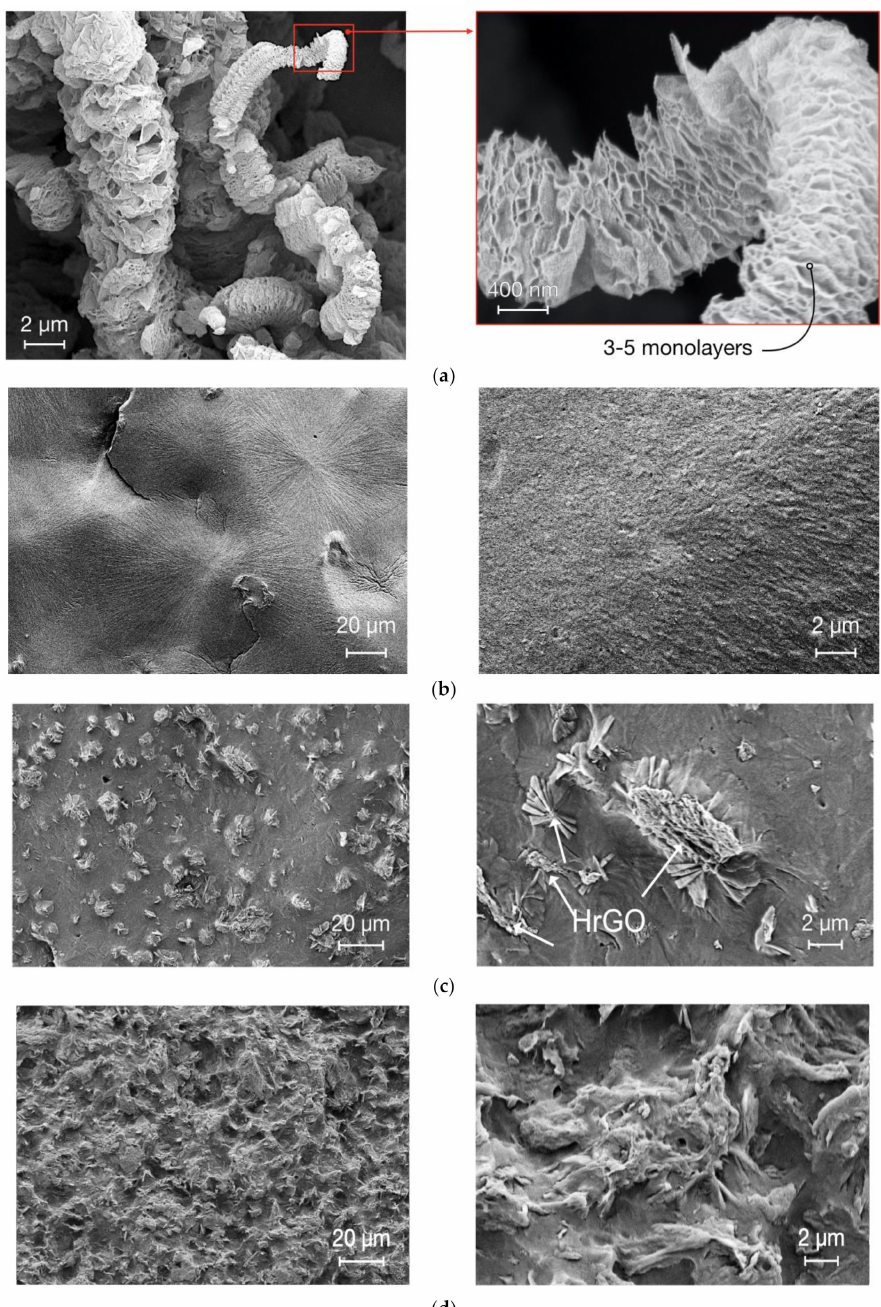
Figure 1. Morphology via scanning electron microscopy (SEM) for ( a ) the 3D hierarchical reduced graphene oxide (HrGO) in powder form, ( b ) the polypropylene (iPP) matrix ( c ) iPP-HrGO with filler loading of 2 wt.% and ( d ) 4